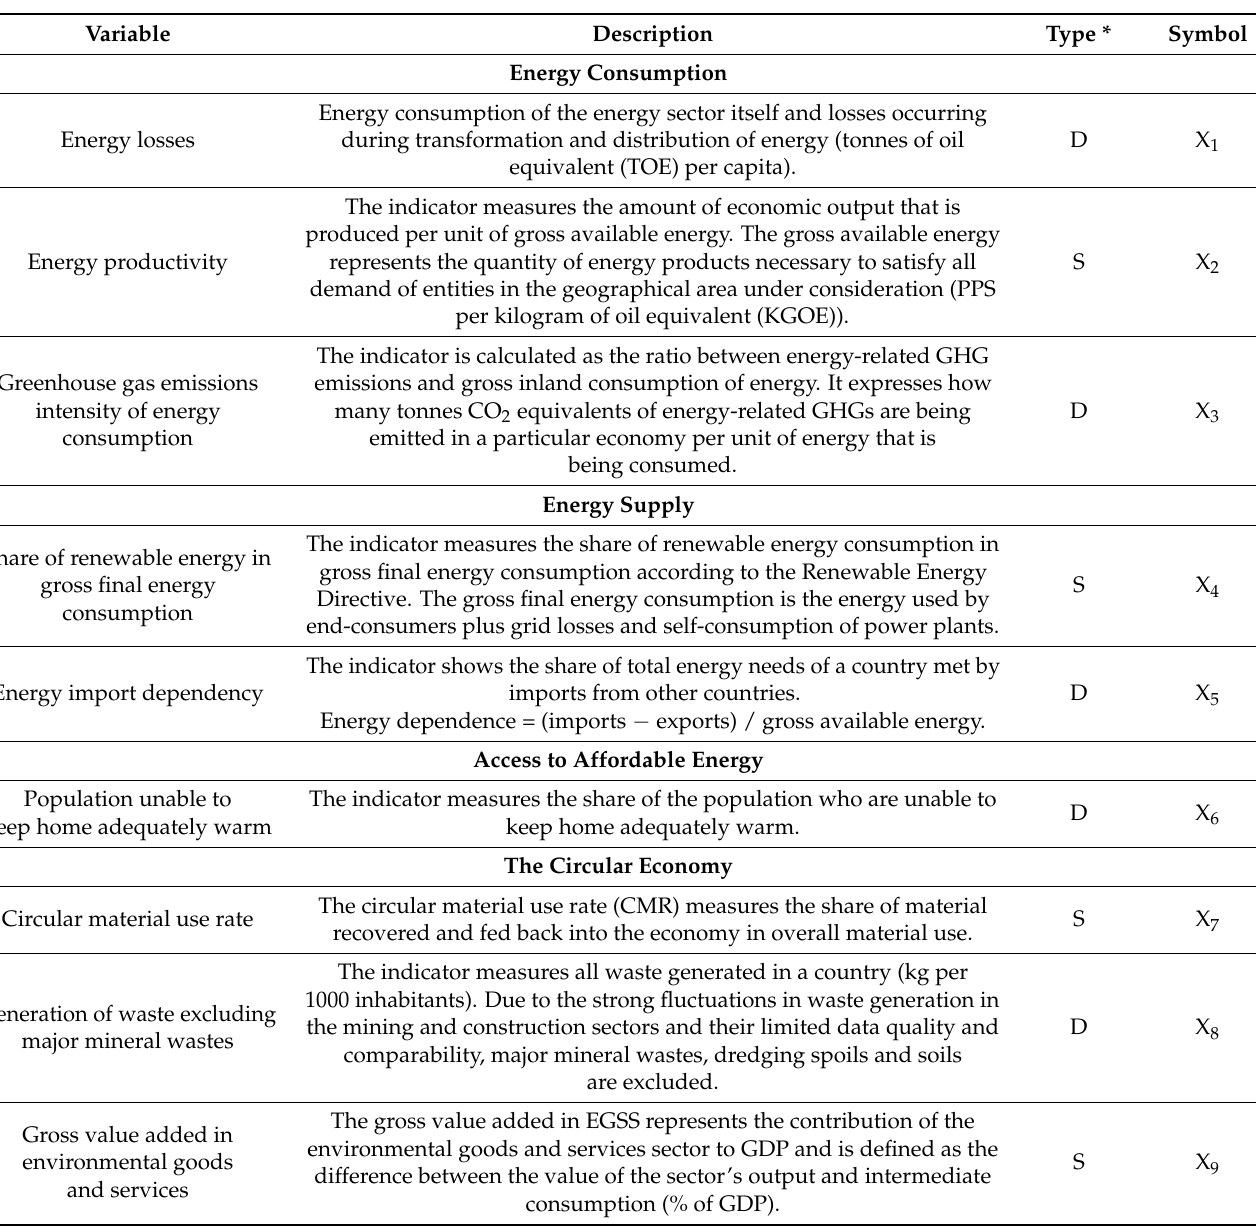
Table 1. Indicators related to the “smart and efficient energy systems” aspect of energy